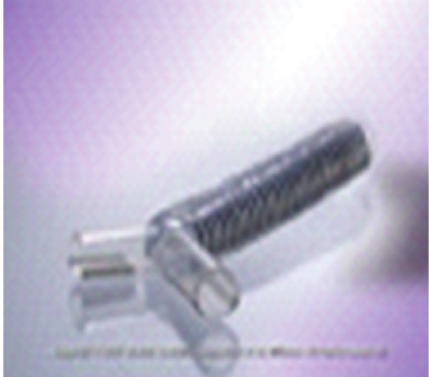
Figure 3: Dynamic